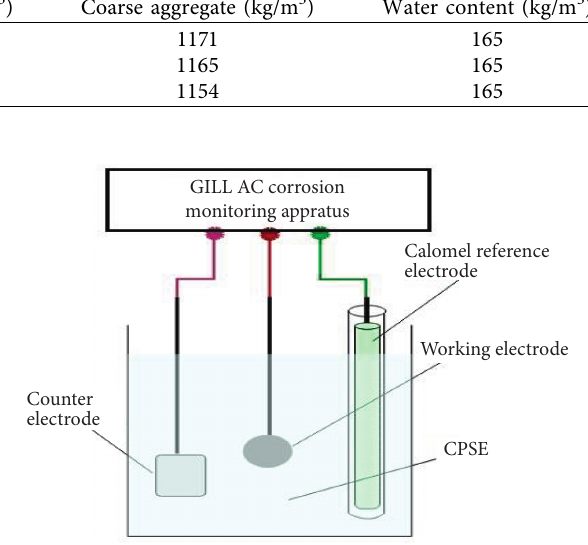
Figure 2: Line diagram of experimental arrangement for poten- tiodynamic linear sweep